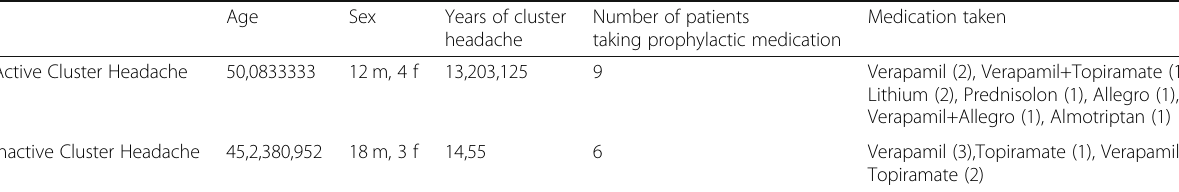
Table 1 Characteristics of the investigated patients